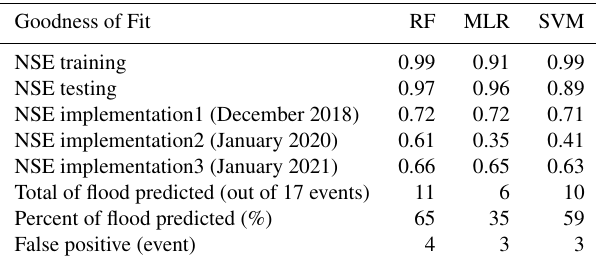
Table 3. Performance of the three machine learning (ML) algo- rithms in implementation